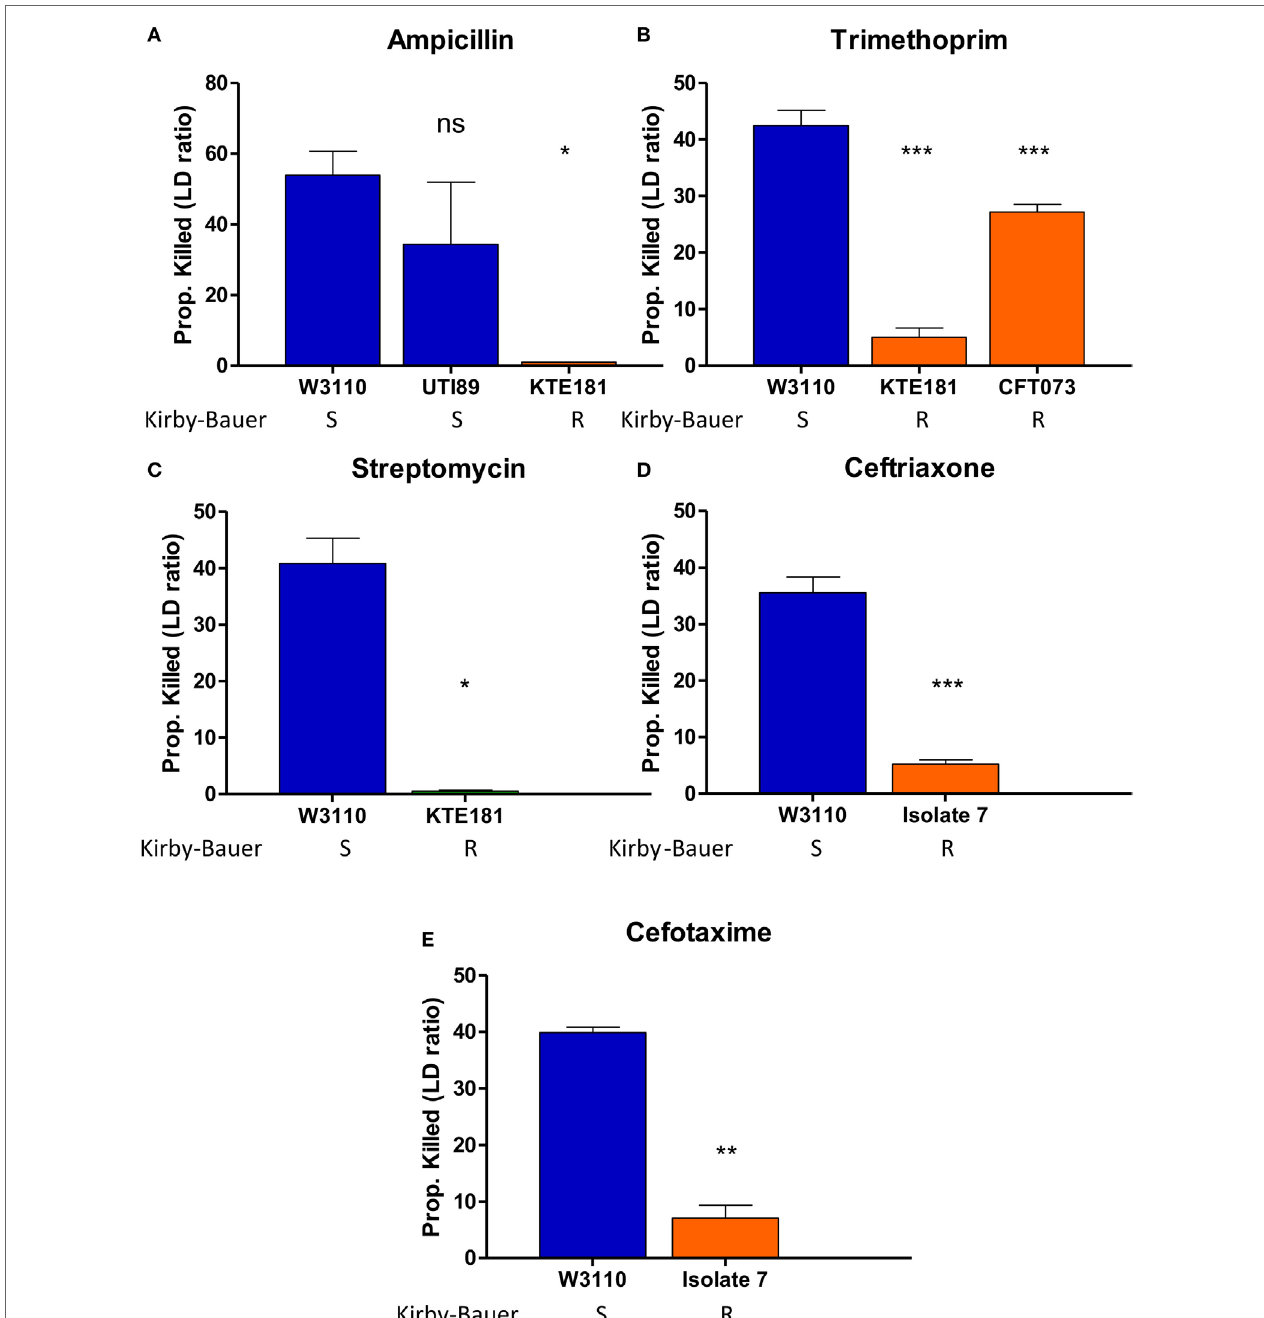
FigUre 4 | SYBR Green I/propidium iodide (PI) stain can distinguish between R (resistant) and S (sensitive) strains of Gram-negative pathogens against various antibiotics in 30 min. Treatment with (a) ampicillin (100 µg/ml), (B) trimethoprim (50 µg/ml), and (c) streptomycin (50 µg/ml) was added to overnight cultures of Escherichia coli strains diluted to 1:25 (OD600 = 0.1). Treatment with (D) ceftriaxone (25 µg/ml) and (e) cefotaxime (50 µg/ml) was added to overnight cultures of Klebsiella pneumoniae strains diluted to 1:25 (OD600 = 0.1). After incubation with antibiotics for 30 min, SYBR Green I/PI staining was performed and distinguished their respective susceptibility categories. All susceptibility results were in concordance with results from the Kirby–Bauer disk diffusion test (Student’s t -test, * p < 0.05, ** p < 0.05, *** p < 0.0005). Data represent the means +